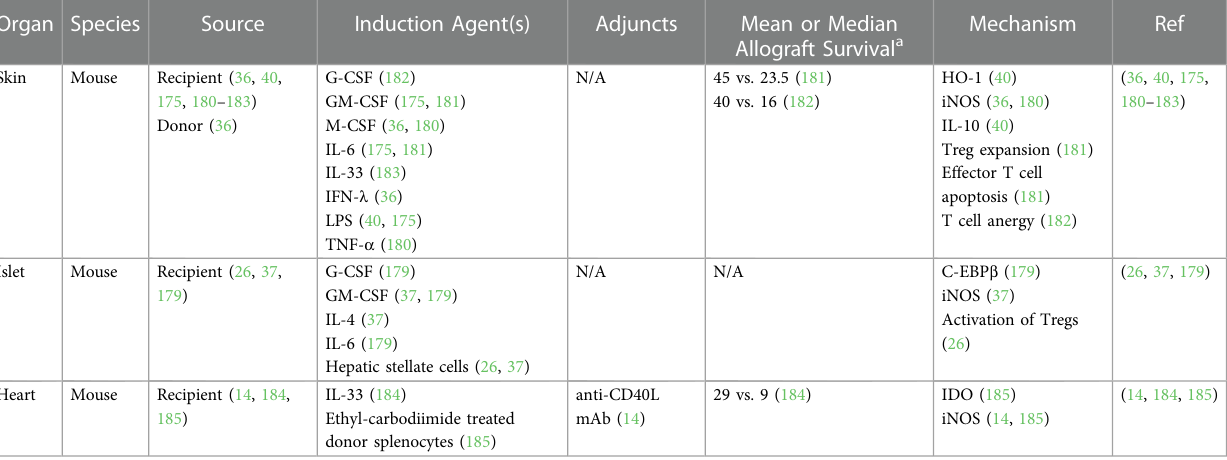
TABLE 1 Studies of MDSCs in animal